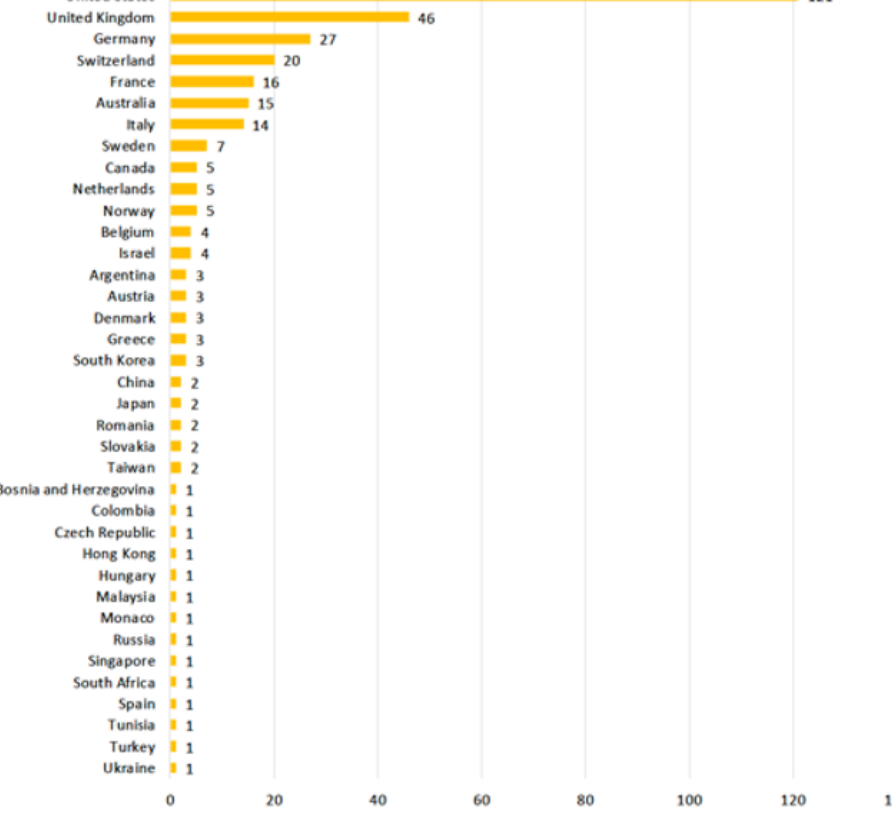
Figure 2: Investigations Concerning Bribery of Foreign Officials by